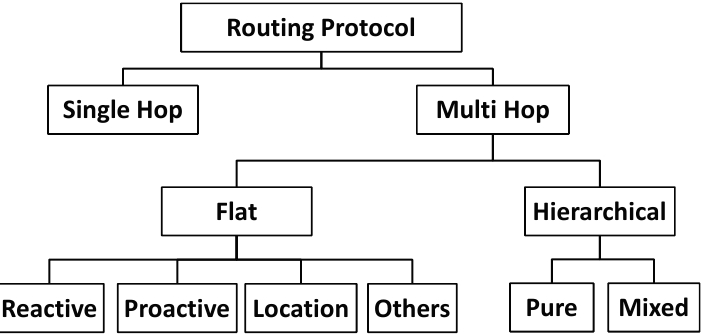
Figure 1. Taxonomy of routing protocols.